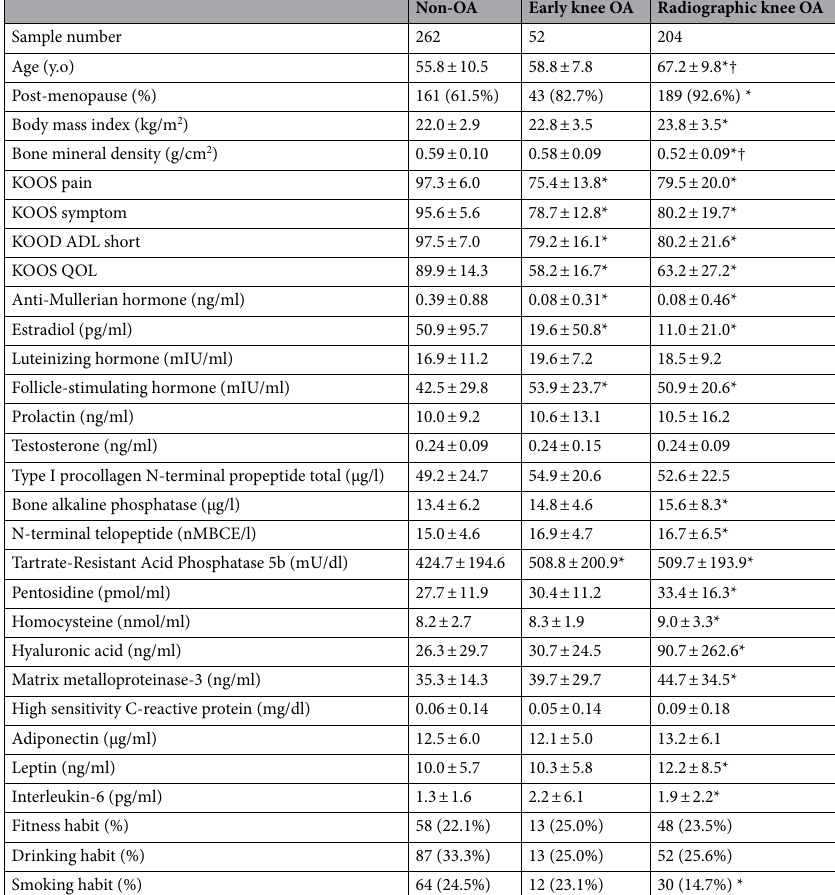
Table 1. Demographic data of non-KOA, early knee OA, and radiographic knee OA groups. Values are means ± standard deviation of the demographic data. Values in () indicate percentage in each group. Differences among the non-OA, early knee OA, and radiographic knee OA groups were compared by analysis of variance or chi-square test. A p value below 0.05 when compared with non-OA (*) and early knee OA (†) were considered statistically significant. KOOS The knee injury and osteoarthritis outcome scores, ADL Activities of daily livings, QOL Quality of